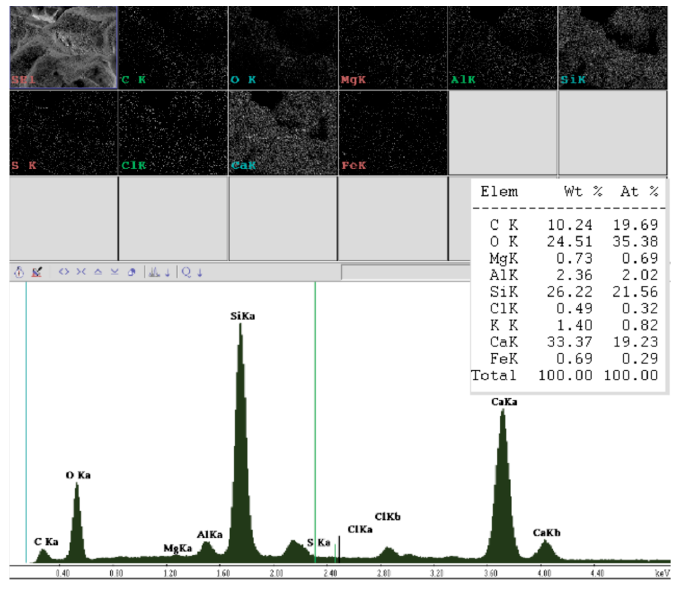
Figure 16. EDS spectrum, i.e., the elemental composition of the tested product modified with a predetermined admixture (the main components are: Si, O, and Ca). Al, Mg, and S are elements found in sand.